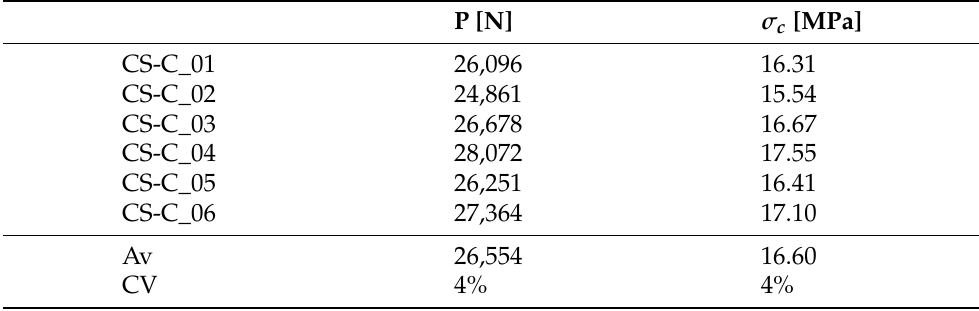
Figure 6. Stress–strain diagrams for uniaxial compression tests (CS-C). Table 3. Results of uniaxial compression tests (CS-C) in terms of maximum load P and maximum compression stress σ c